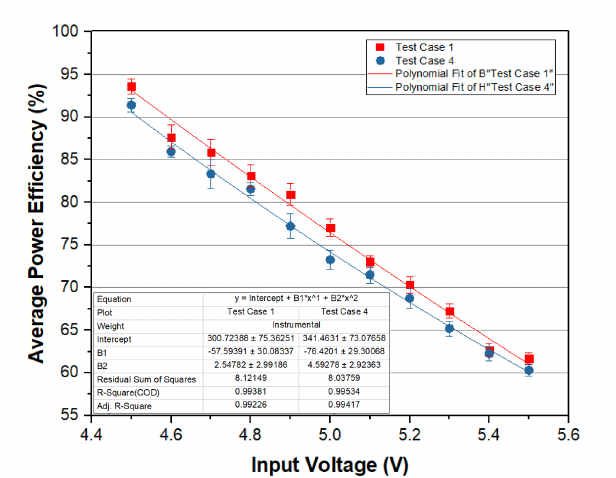
Figure 11. Comparison of performance for fully on-chip or fully on-board integration of LED and FET